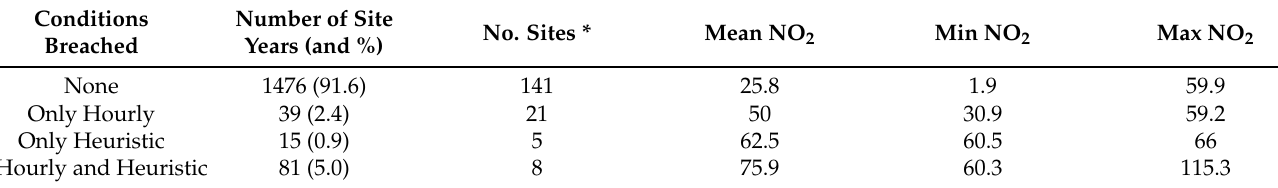
Table 3. Sensitivity test data. Summary of data for all site types in the AURN dataset, examining the cartesian product of whether the heuristic threshold is met (>60 µ g/m 3 annual mean) and whether the hourly threshold is met (more than 18 h >170 µ g/m 3 ). The last four columns show mean, minimum, maximum, and standard deviation of measured NO 2 for each category (in µ g/m 3 ). * A site can be in more than one set because it can differ from year-to-year and so the total of the column exceeds the total number of sites